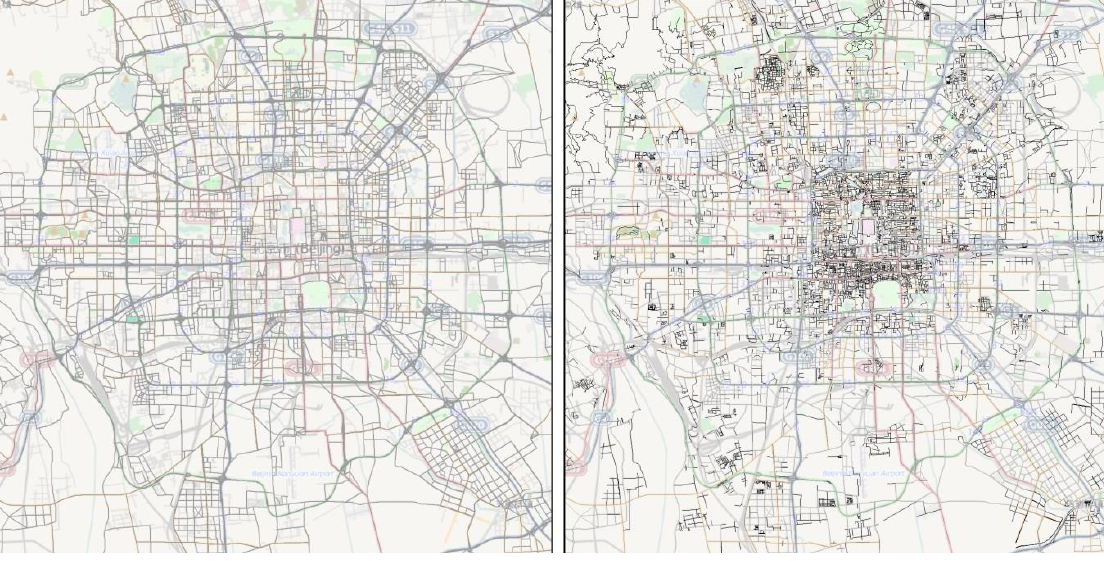
Figure 1. Network